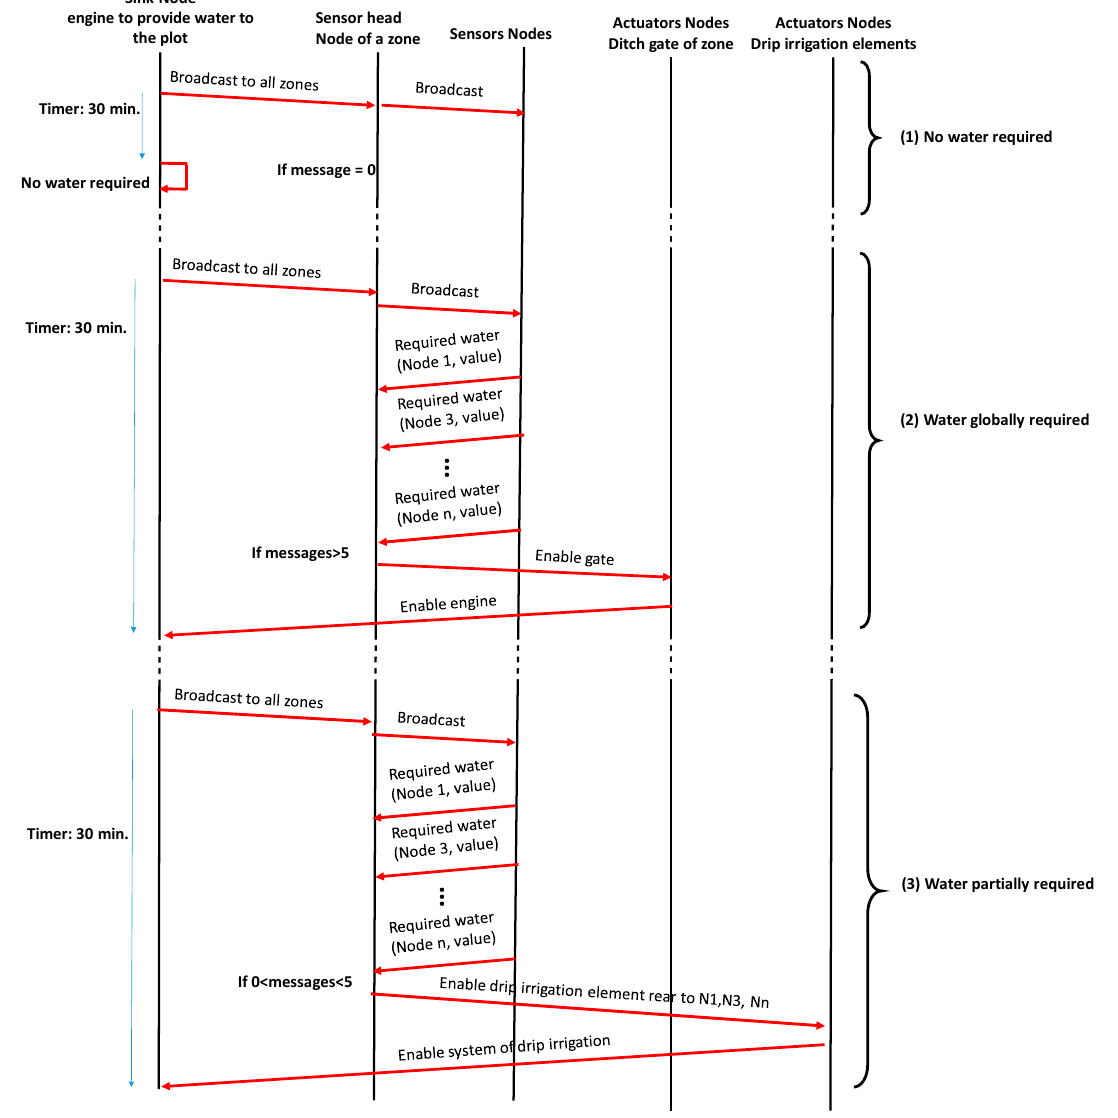
Figure 12. Message exchange between nodes.